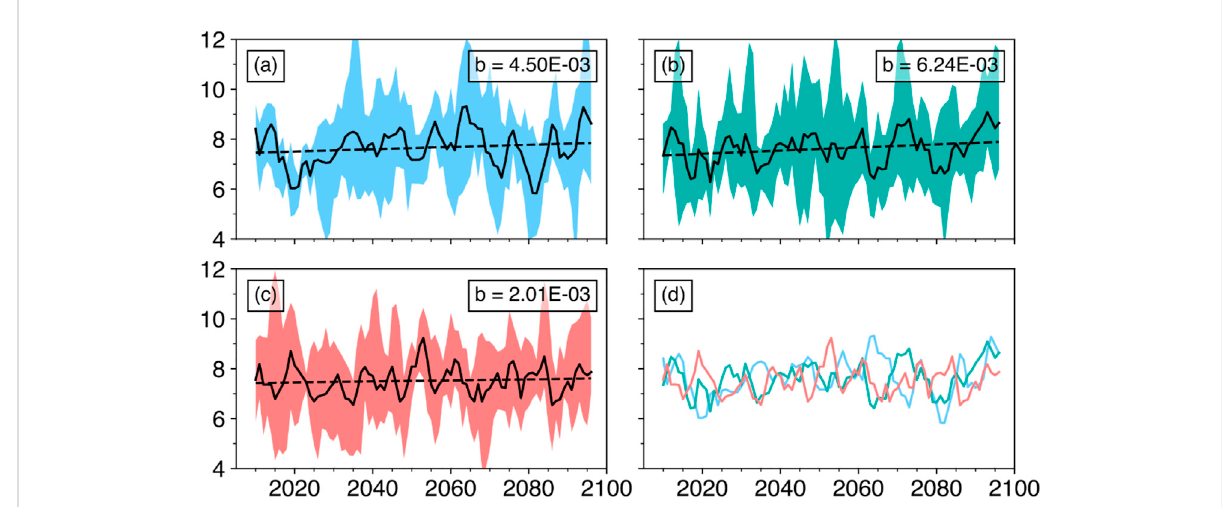
FIGURE 3 Annual numbers of tropical cyclones identi fi ed by the algorithm from simulations under the (A) 1.5degNE, (B) 1.5degOS, and (C) 2.0degNE scenarios. 9-Year moving means are taken from 2006 to 2100. The shaded area represents the ensemble range, the black solid line the ensemble mean,andtheblackdottedlineresultoflinearregression. (D) Ensemblemeansoftheannualnumberoftropicalcyclonesfromaveragedvaluesinthe 1.5degNE (blue), 1.5degOS (green), and 2.0degNE (red) scenarios.